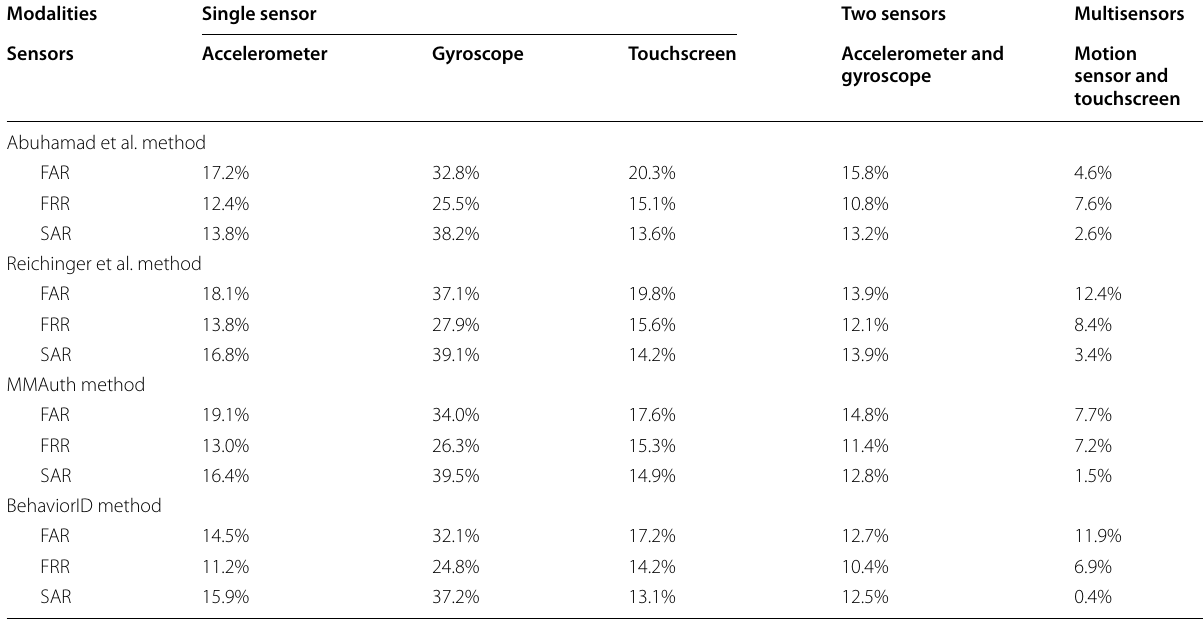
Table 3 Estimated values of FAR, FRR, and SAR for password-based password’s length (fixed-context in-house dataset) with modern and proposed methods